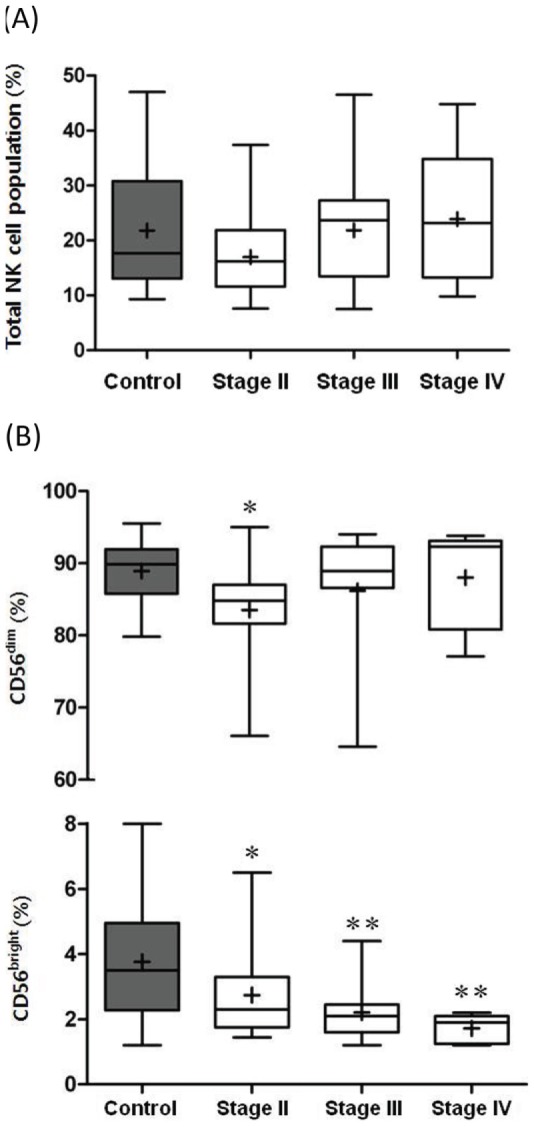
(A) Boxplot diagrams showing flow cytometric distribution results of total NK cell population % between controls and patients, grouped according to cancer stage.No significant differences of total NK population were noted between patients and controls, and within stage groups. (B) Boxplot diagrams showing flow cytometric distribution results of CD56dim and CD56bright subset distributions within total NK cells between controls and patients, grouped according to cancer stage. *p<0.05, **p<0.01 in relation to controls.